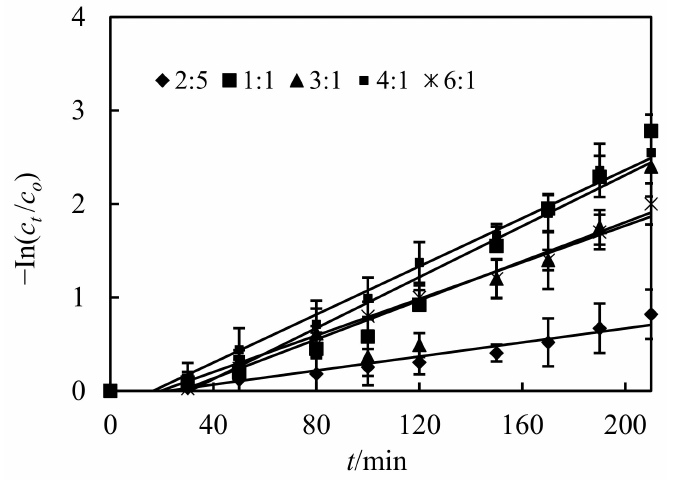
Figure 8. Impact of volumetric ratio of sheeting liquor and hydrochloric acid liquor on dislodging of